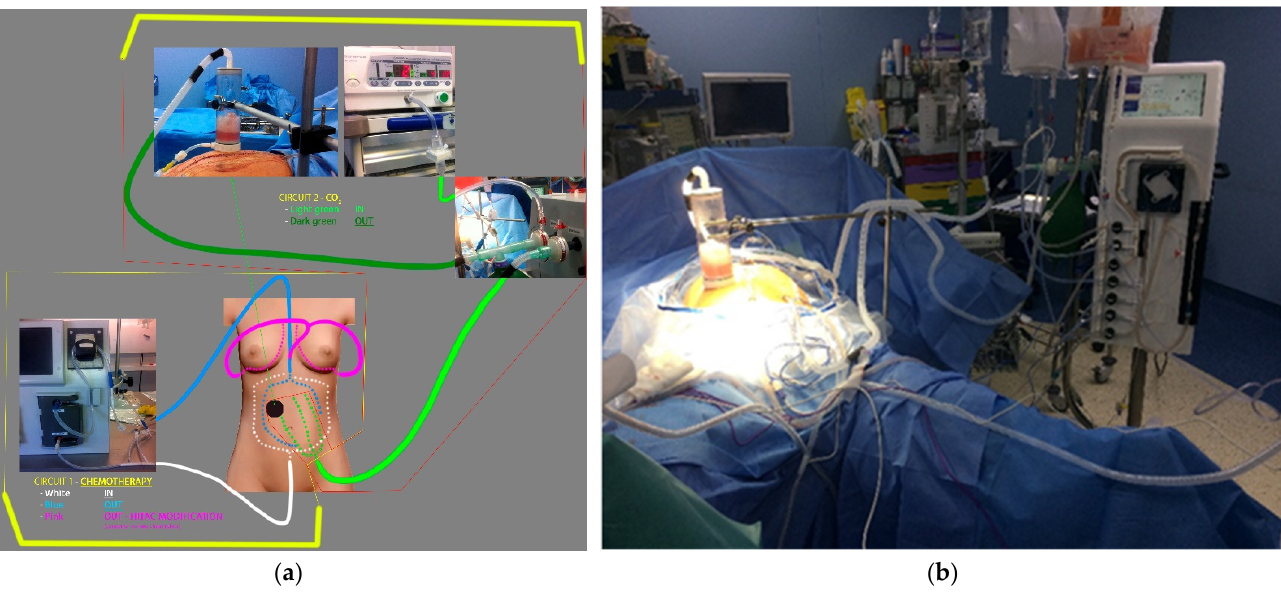
Figure 3. HIPEC and HITAC schematic view. Part ( a ) schematic view of the HIPEC system (white IN- blue OUT for chemotherapy, light green IN-dark green OUT for CO 2 ; in pink, the HITAC modification, allowing chemotherapy recover from pleural cavities. Part ( b ) real intraoperative setting of HIPEC with Combat PRS®(Author: E.